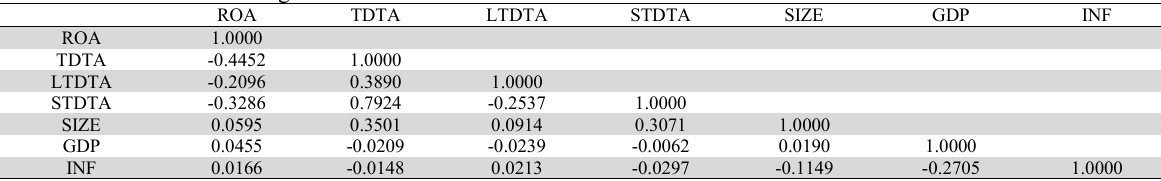
Table 3 indicates that independent variables of TDTA, LTDTA and STDTA are negatively correlated with ROA. Meanwhile, control variables of SIZE, GDP and INF are positively associated with ROA.